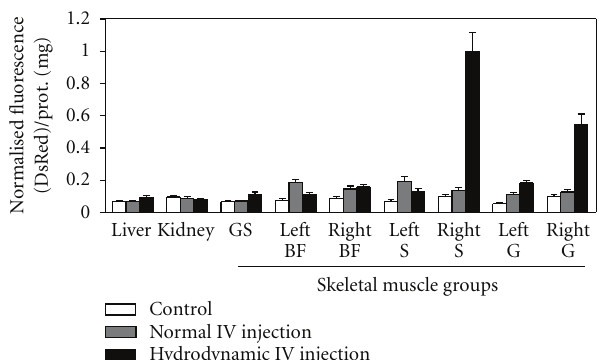
Figure 1: Hydrodynamic injection on hindlimb of rat. The experimental detail of hydrodynamic injection procedure was given in section of Materials and Methods.